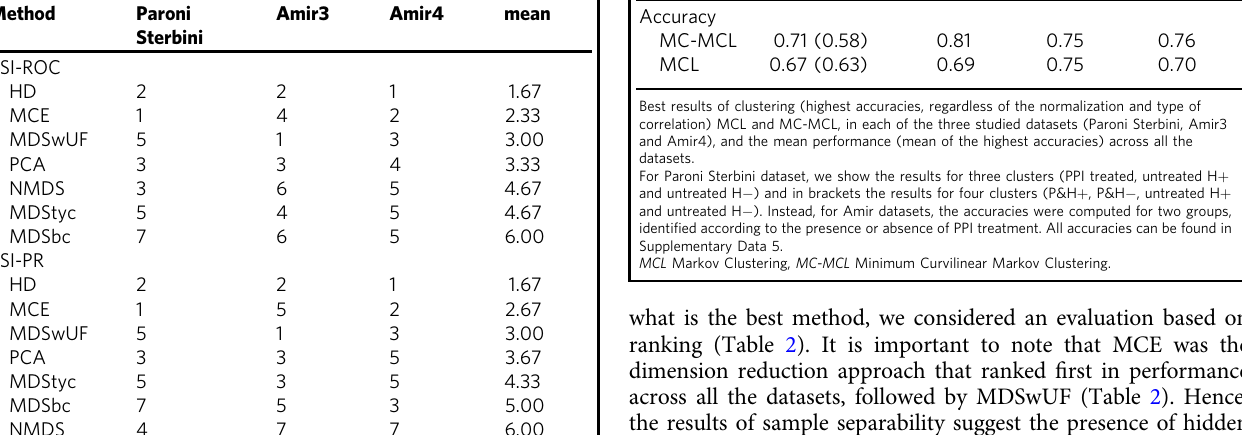
Table 3 Results of clustering on the real dataset.